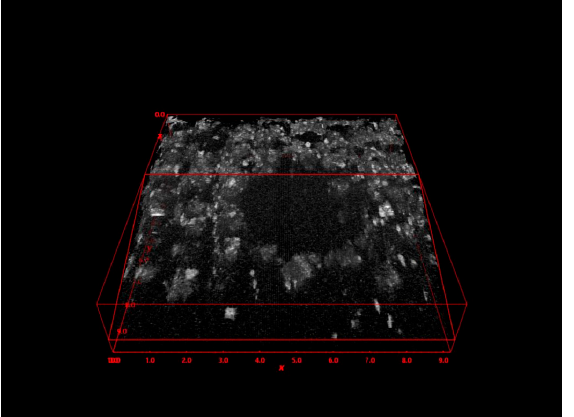
Figure 5. Volume reconstruction for the qualitative evaluation of the microarchitecture. Scanning was completed in a volume of 10 mm × 10 mm. This is a 3D image of the coronal section of the Densah burs group in counterclockwise drilling.